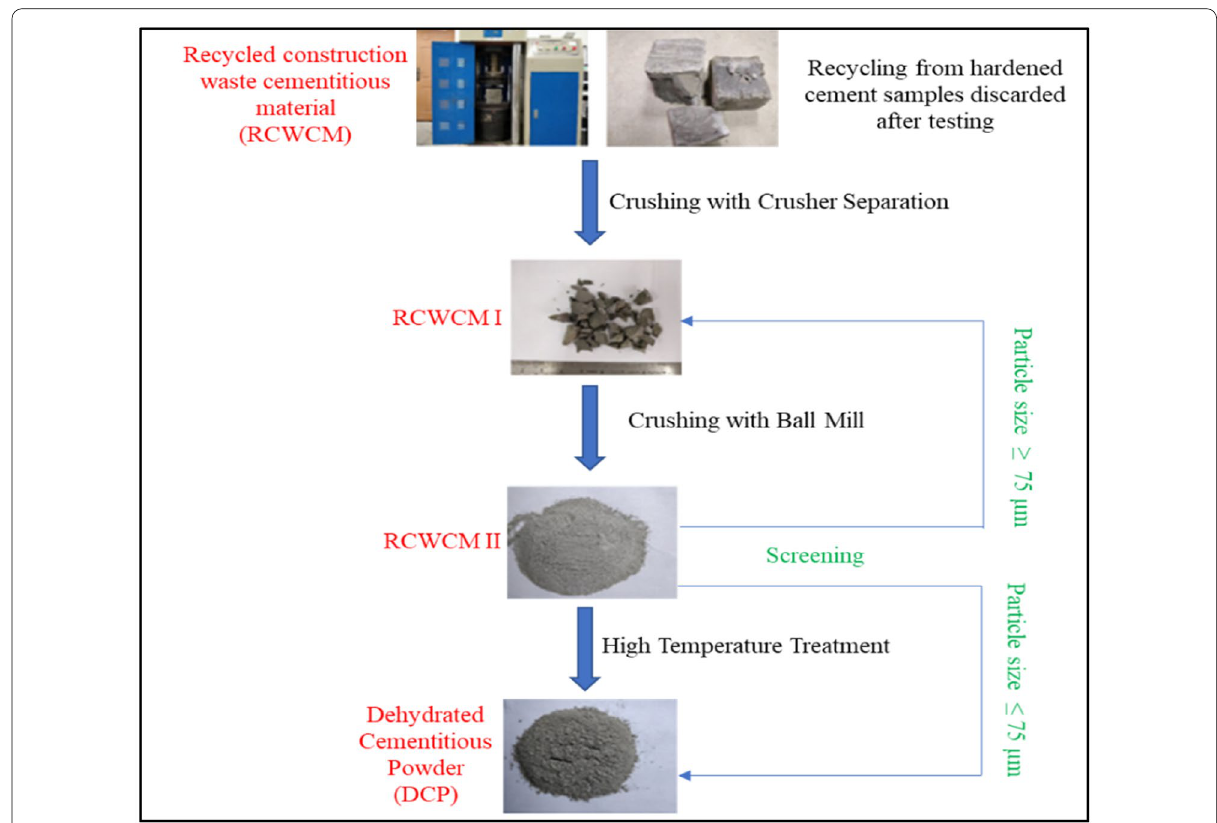
Fig. 4 Thermal activation of WCP (Qian et al., 2020; Sui et al.,